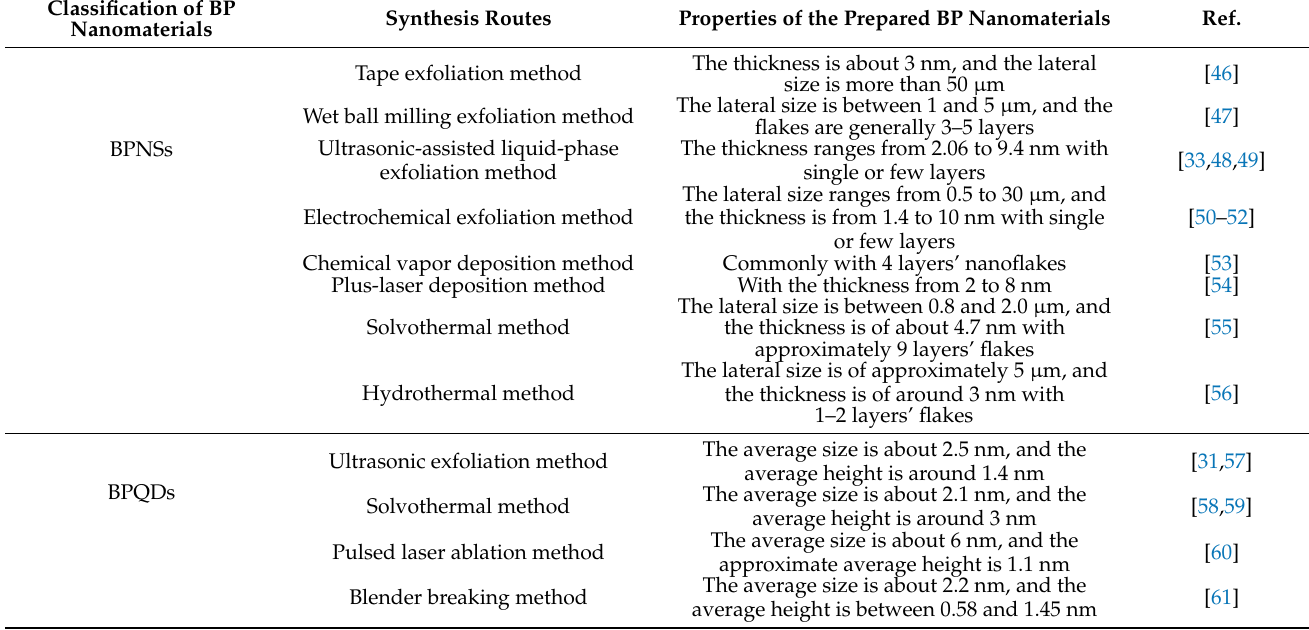
Table 1. Examples of various synthesis routes for the preparation of BP nanomaterials. Classification of BP Synthesis Nanomaterials